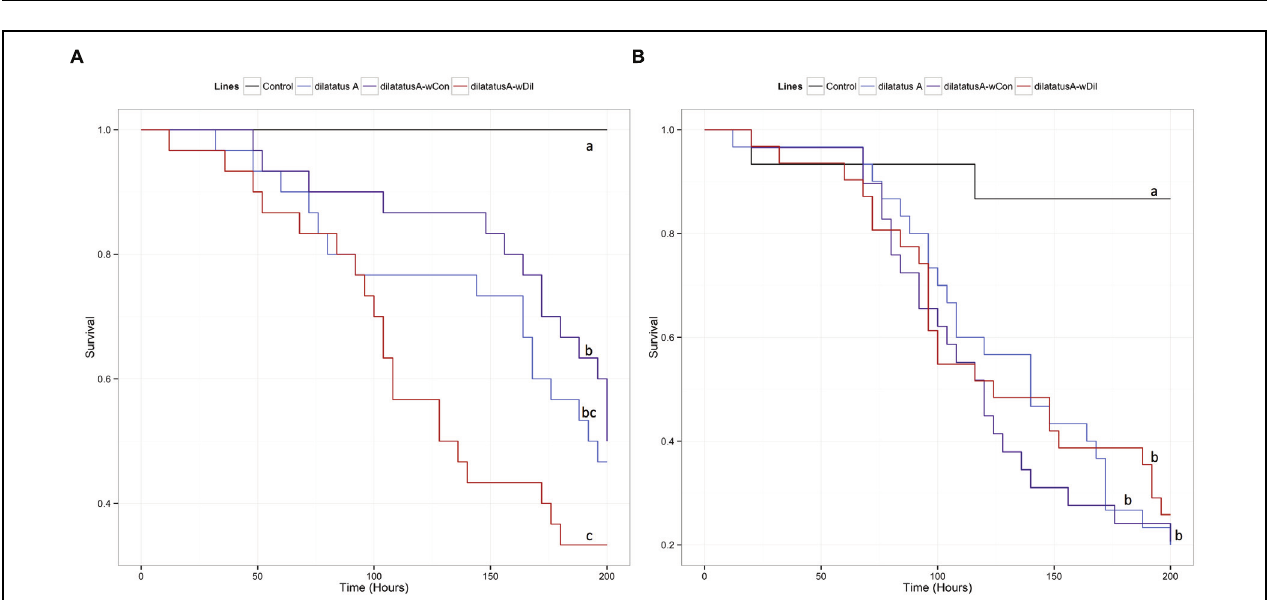
FIGURE 6 | Survival of the different P. dilatatus lines when infected with L. ivanovii . A Cox proportional hazards model was fitted using the survival data of symbiotic ( dilatatus A- w Con, dilatatus A- w Dil) and asymbiotic ( dilatatus A) individuals after being injected with pathogenic bacteria L. ivanovii . Results for females (A) and for males (B) are presented separately. Control groups were injected with liquid medium (BHI). Different letters indicate significant differences between the survival curves of different lineages based on log-rank test. p < 0.05.